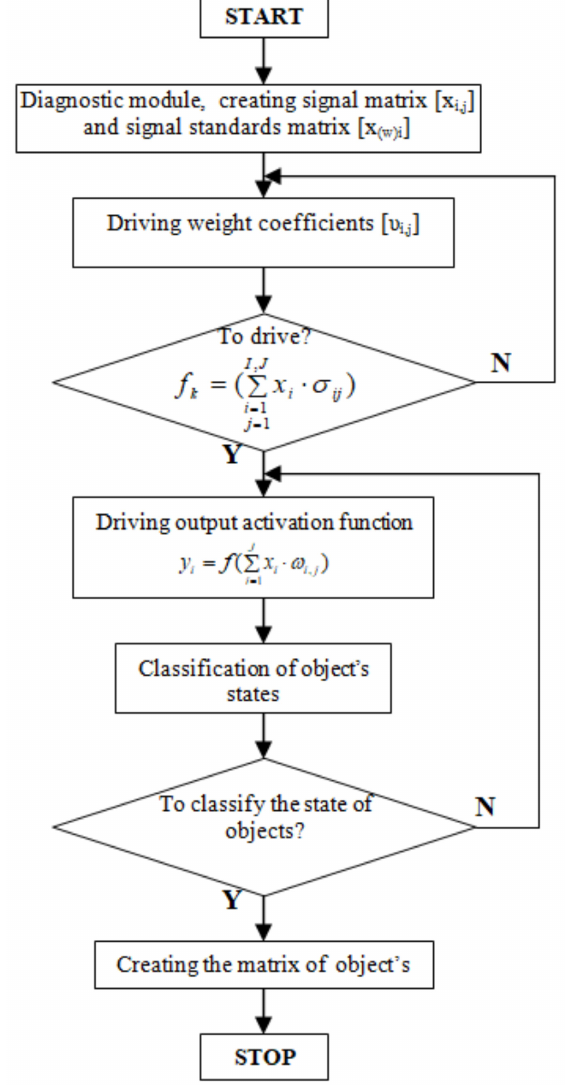
Figure 3. The algorithm of diagnostic program DIAG.